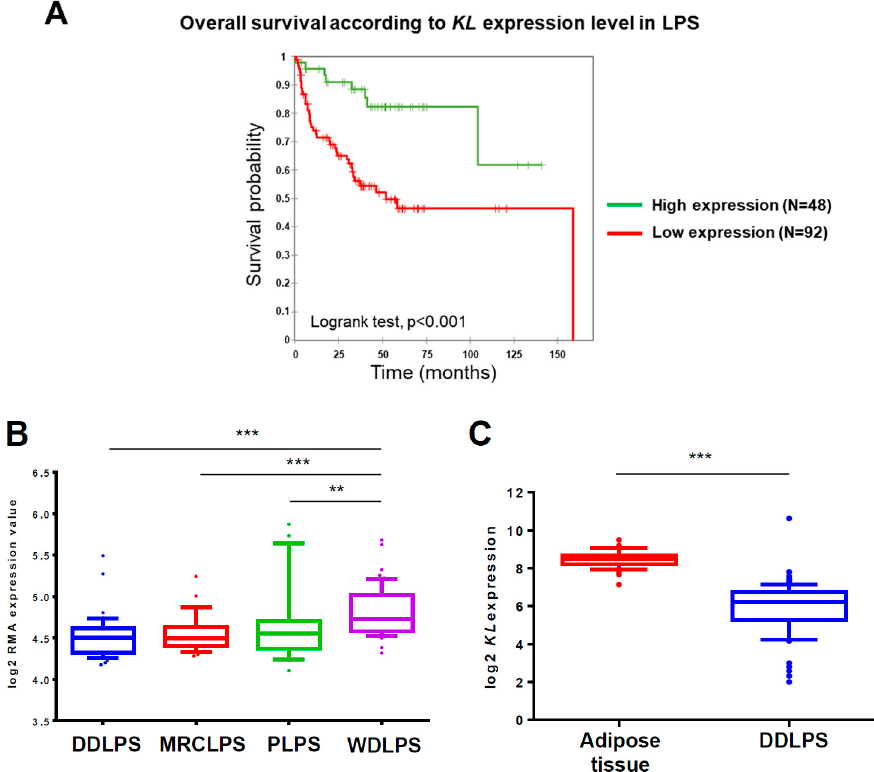
Figure 1. Klotho ( KL ) expression has a prognostic value for liposarcoma patients and is downregulated in dedifferentiated liposarcomas (DDLPS) tumors ( A ) Kaplan-Meier curves of the overall survival in 140 liposarcoma patients divided into high- and low-risk groups according to the expression level of KL in tumors (high or low, cut-off = mean) determined by microarrays (dataset ID: GSE30929). Higher KL expression is significantly associated with a better survival for liposarcomas (LPS) patients (Log-rank test, p < 0.001). ( B ) A boxplot of KL mRNA expression in dedifferentiated (DDLPS, n = 40), myxoid round cell (MRCLPS, n = 28), pleomorphic (PLPS, n = 20), and well-differentiated (WDLPS, n = 52) liposarcomas profiled on a gene expression microarray (dataset ID: GSE30929). KL expression is significantly (** p < 0.01 and *** p < 0.001) higher in WDLPS tumors compared to other histotypes. ( C ) A boxplot of KL mRNA expression in adipose tissue ( n = 49) and DDLPS tumors ( n = 61) profiled on gene expression microarray (GSE13506 and GSE21050, respectively) and normalized by GENT database. KL expression is significantly ( p < 0.001) reduced in DDLPS tumors compared to adipose tissue. On the boxplots, the line in the middle of the box is the median; the whiskers are drawn down to the 10th percentile and up to the 90th. Points below and above the whiskers are represented as individual